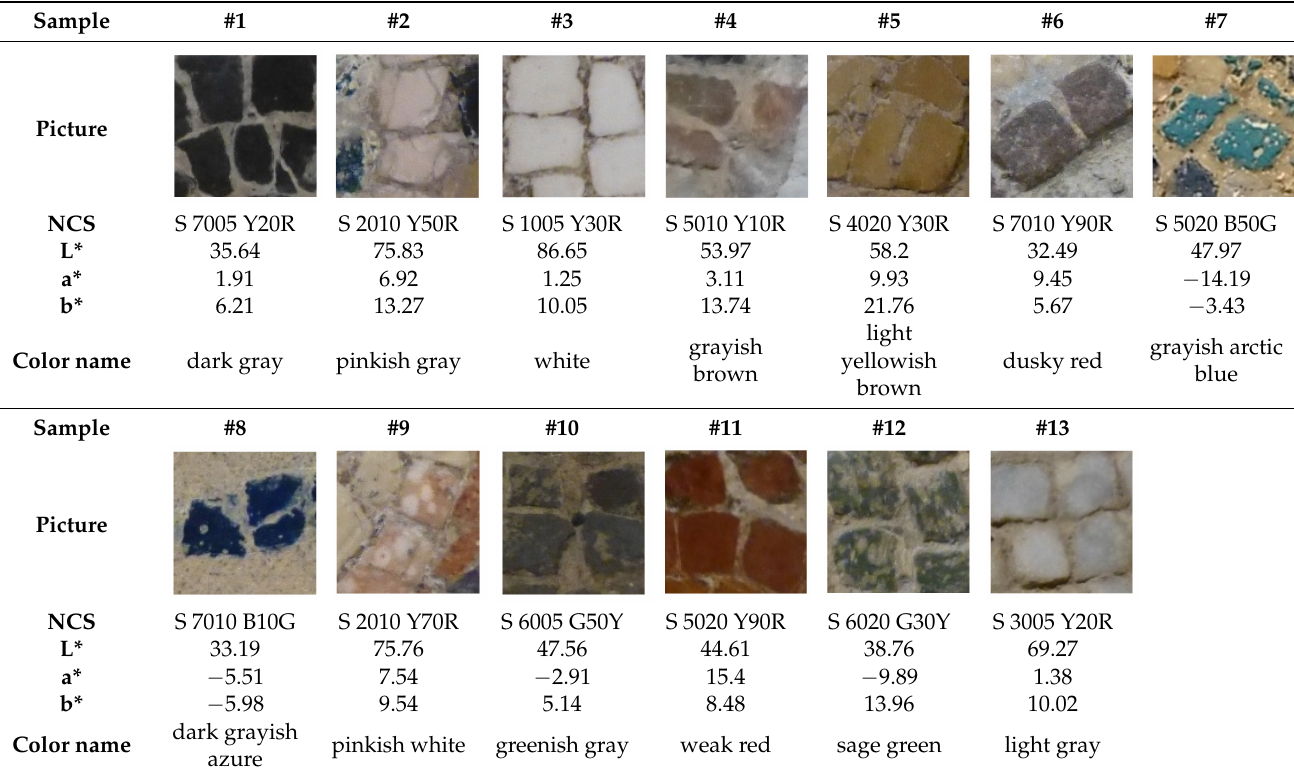
Table 1. Table includes close-up images of the thirteen sampled types of tesserae and their measured colors using both NCS and CIELAB systems, the color name corresponds to the closest Munsell